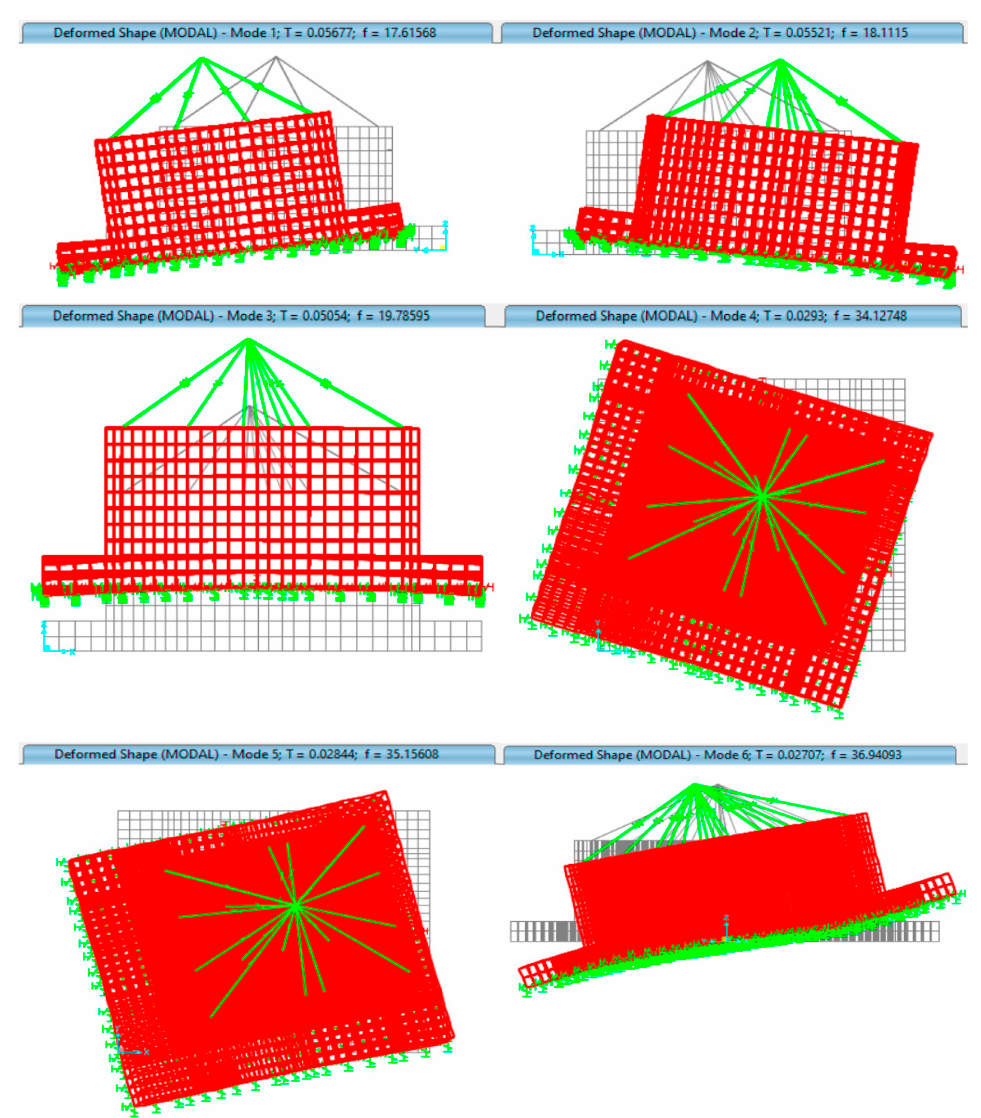
Figure 11. The modal shapes obtained from FEA (in grey the undeformed shape).